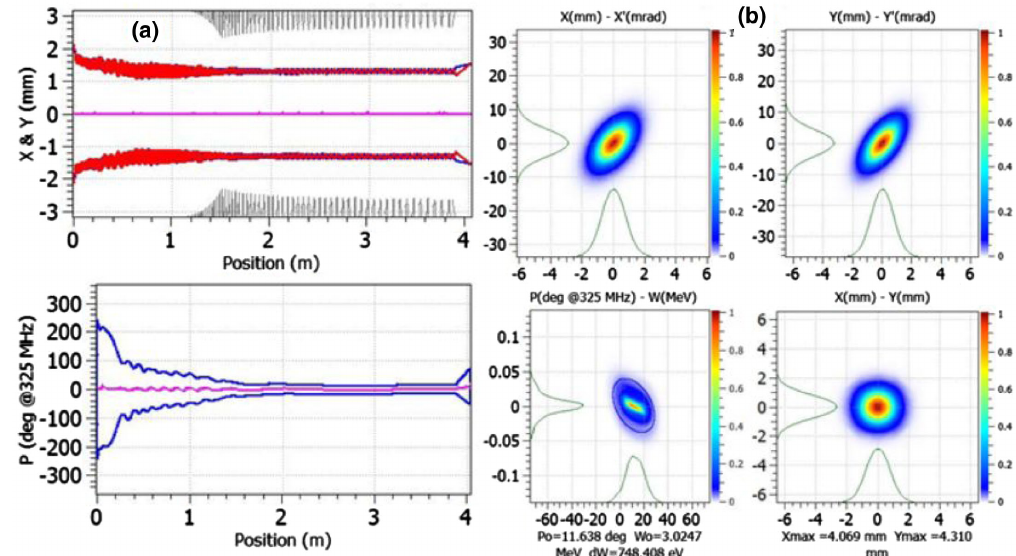
FIG. 10. (a) Beam envelope (x in red and y in blue) along the RFQ, and variation of beam phase width along RFQ, and (b) phase space (x-x ’ , y-y ’ and phase-energy) and coordinate (x-y) space particle distribution at the exit of RFQ, for the beam current of 10 mA.